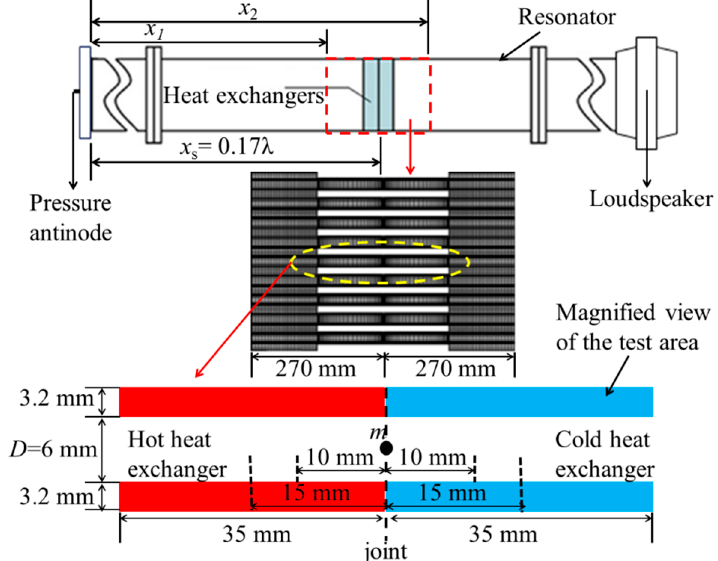
Figure 1. A “short model” shown as a red-dashed box on the schematic diagram (top); computational domain (middle); and the area of the parallel-plate channel investigated (bottom).